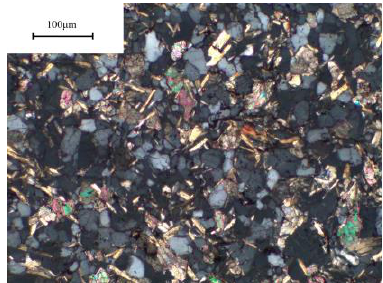
Figure 2. Microstructure of sandstone.